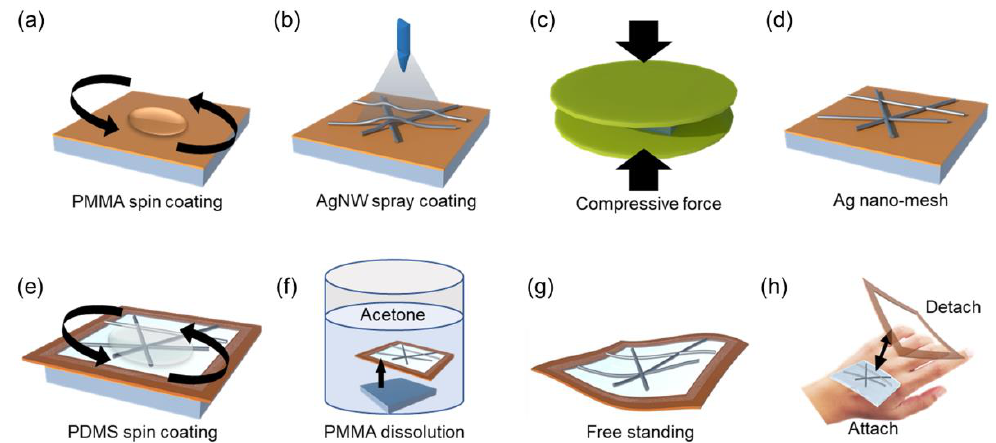
Figure 1. Schematic illustration of the fabrication process for the embedded silver nanowire (AgNW) nanomesh transparent skin electrode. ( a ) The PMMA was first spin-coated on the SiO 2 substrate and baked on the hotplate. ( b ) A solution of AgNWs was spray-coated on the PMMA-coated substrate using spray equipment. ( c , d ) Mechanically pressurized to weld the AgNW junctions, then obtained the 2D Ag nanomesh. ( e ) Liquid PDMS was spin-coated on AgNWs/PMMA/SiO 2 substrate, and thermal curing. ( f ) Peel-off by itself from the SiO 2 substrate in hot DI water, followed by immersion of the AgNW-embedded PDMS/PMMA in acetone for remove the PMMA layer. ( g , h ) Subsequently rinsed with alcohol and DI water to form a free-standing AgNW-embedded PDMS film.